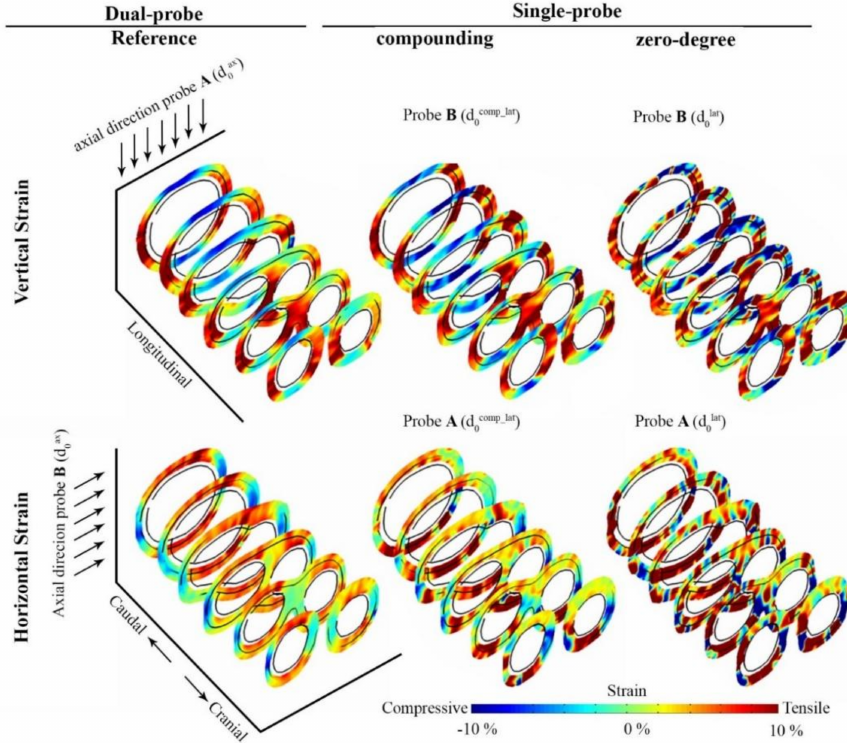
Figure 7. Vertical and horizontal strain estimates of the bifurcation in 3D at maximum systolic pressure. Please note that for visualization purposes, only 6 distinctive transverse slices are depicted at a 3 times larger elevational scale.